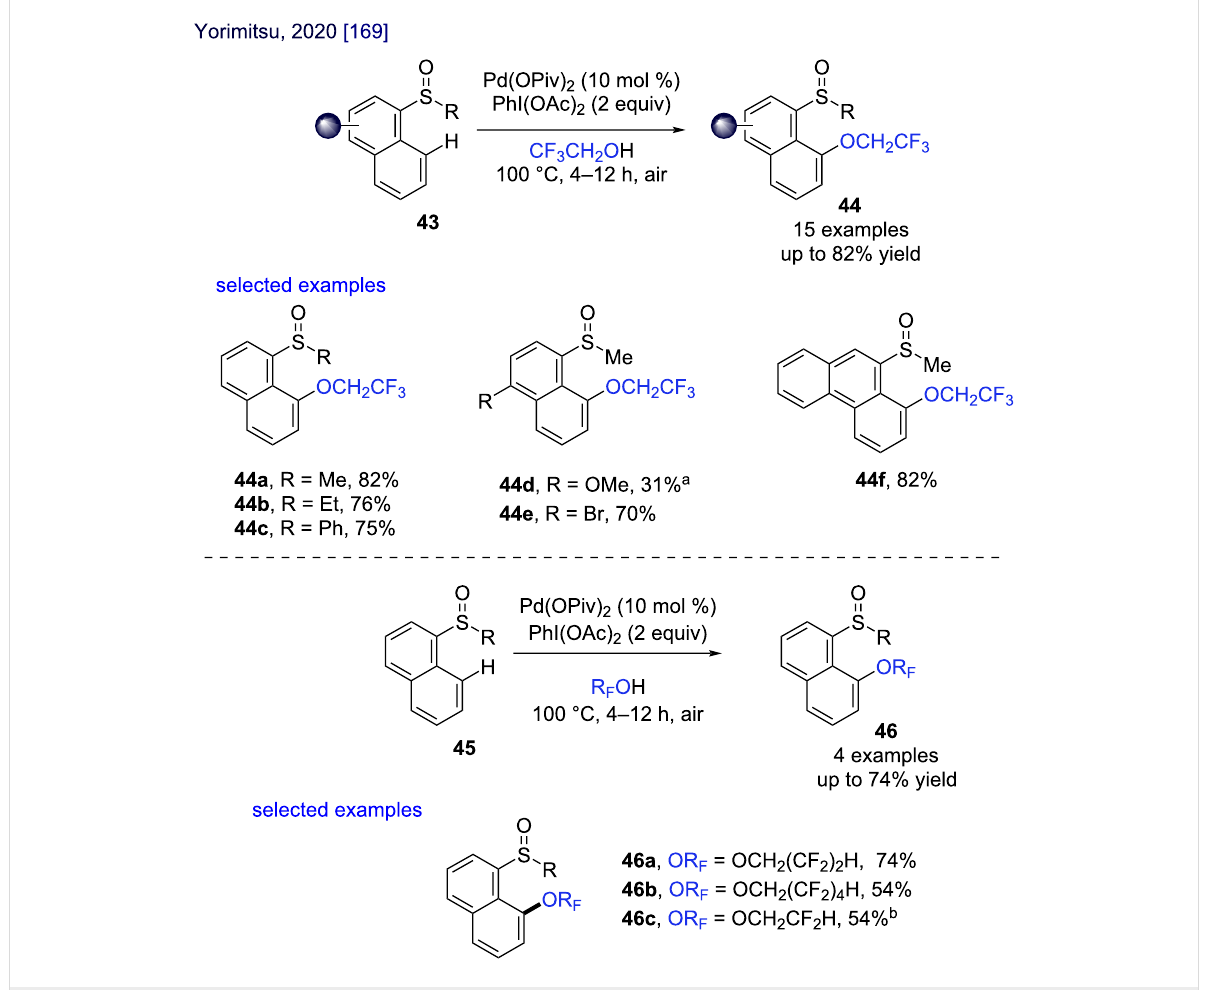
Scheme 21: Pd(II)-catalyzed selective 2,2,2-trifluoroethoxylation and other fluoroalkoxylations of naphthalene sulfoxide derivatives reported by the group of Yorimitsu [169]. a 80 °C for 1 h. b R F OH/AcOH 1:7.